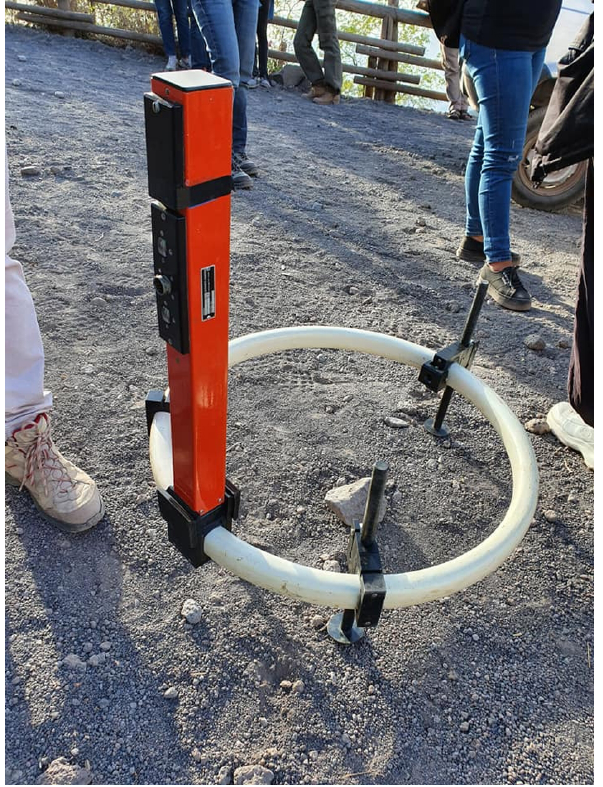
Figure 2. The receiver coil that records the Earth’s EM